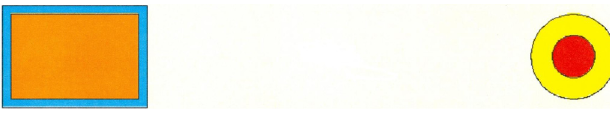
Fig. 5. Detector and source